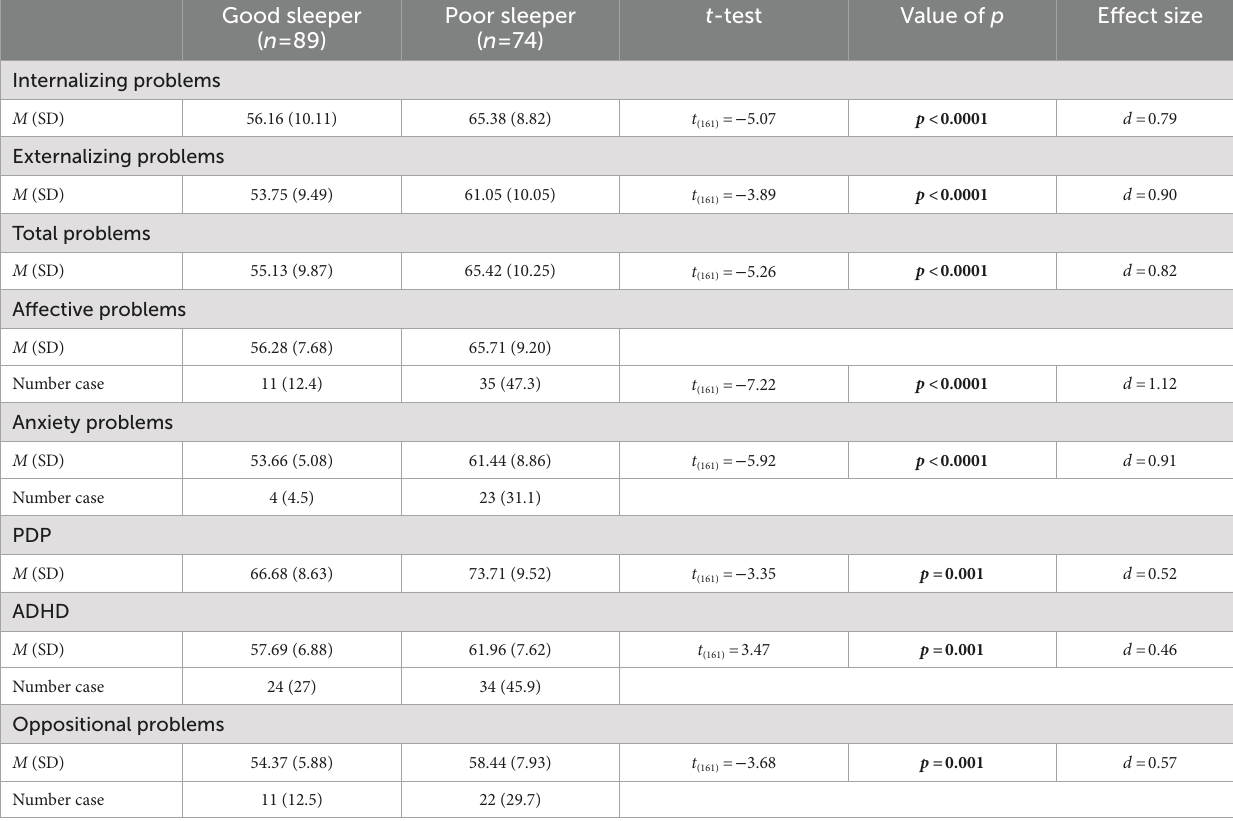
related symptoms (Table 7), in line with previous research that showed